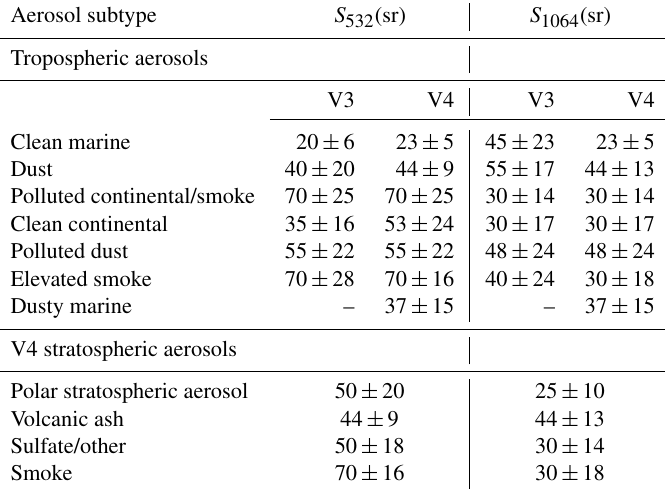
Table 2. Aerosol lidar ratios with expected uncertainties for tropospheric and stratospheric aerosol subtypes at 532 and 1064nm in CALIOP version 3 and 4 aerosol retrieval